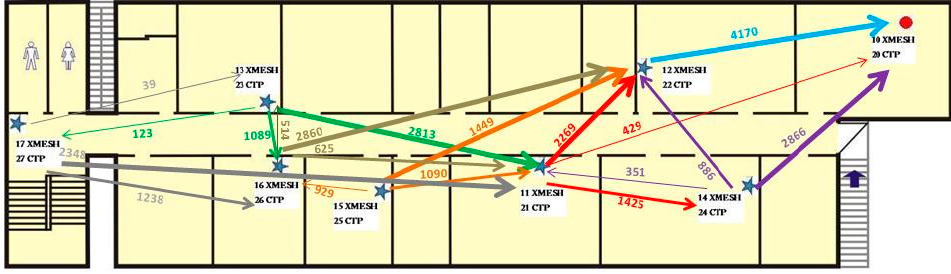
Figure 7. Route distribution for each mote using the XMESH protocol in Experiment 1.